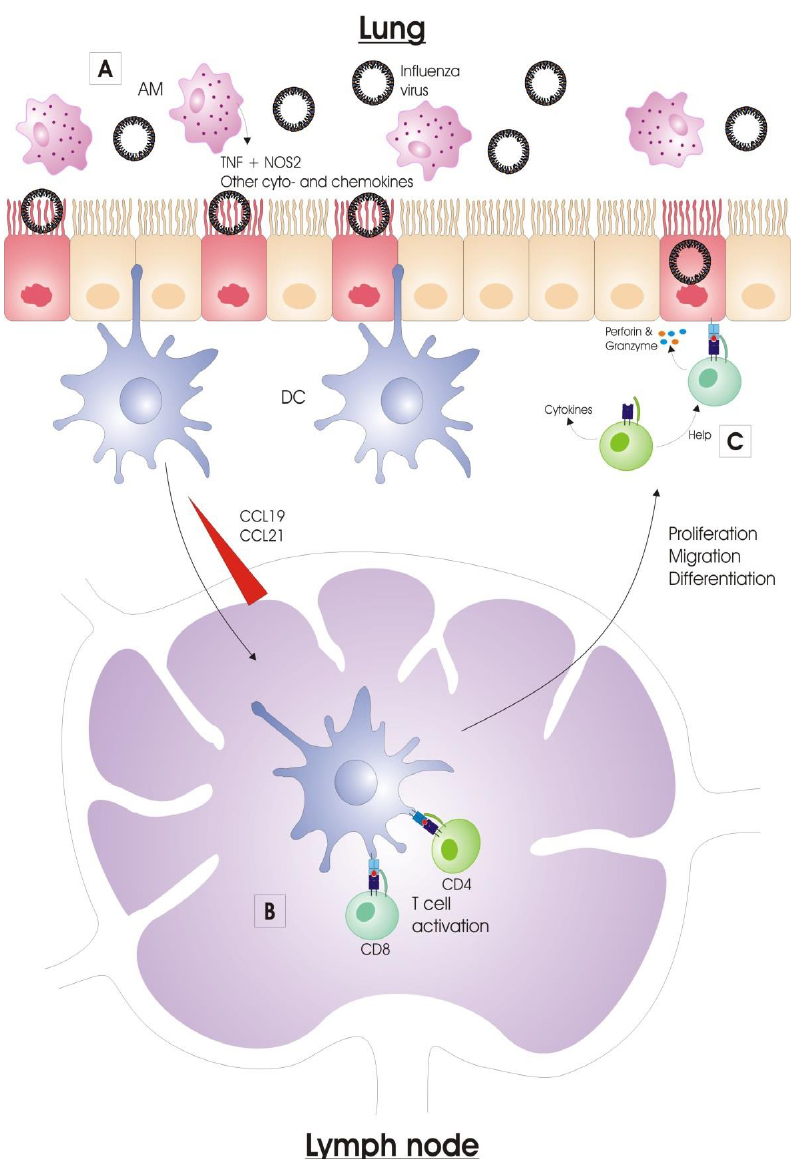
Figure 2. Adaptive immunity against influenza virus infection. ( A ) Alveolar macrophages (AMs) reside in the alveolar lumen and are considered the first immune cell type to encounter respiratory pathogens. Activated AMs produce nitric oxide synthase 2 (NOS2) and tumor necrosis factor (TNF), by which they also contribute to lung pathology upon influenza virus infection; ( B ) Dendritic cells (DCs) are professional antigen-presenting cells (APCs). The conventional DCs (cDCs), which are located underneath the airway epithelium barrier and above the basal membrane, continuously monitor the airway lumen with their dendrites. Once the cDCs acquired viral antigen, they migrate to the draining lymph nodes (DLNs) via a CCL19 and CCL21 chemokine gradient along the afferent lymphatic system. In the LNs, DCs present processed antigen to naïve T cells. The DC degrades viral proteins, and the resulting peptides (antigens) are presented by MHC class I or II proteins for specific CD8 + and CD4 + T cells respectively. The T cells that are specific for the antigen become activated and expand clonally. The newly activated T cells begin to acquire effector functions, and migrate from the LNs to the site of infection; ( C ) CD8 + T cells can kill infected respiratory epithelial cells, and, by this, clear the virus from the lungs. This is done by exocytosis of granules that contain perforins and granzymes. CD4 + T cells on the other hand mainly provide help to other immune cells, and regulate the immune response by producing a vast array of